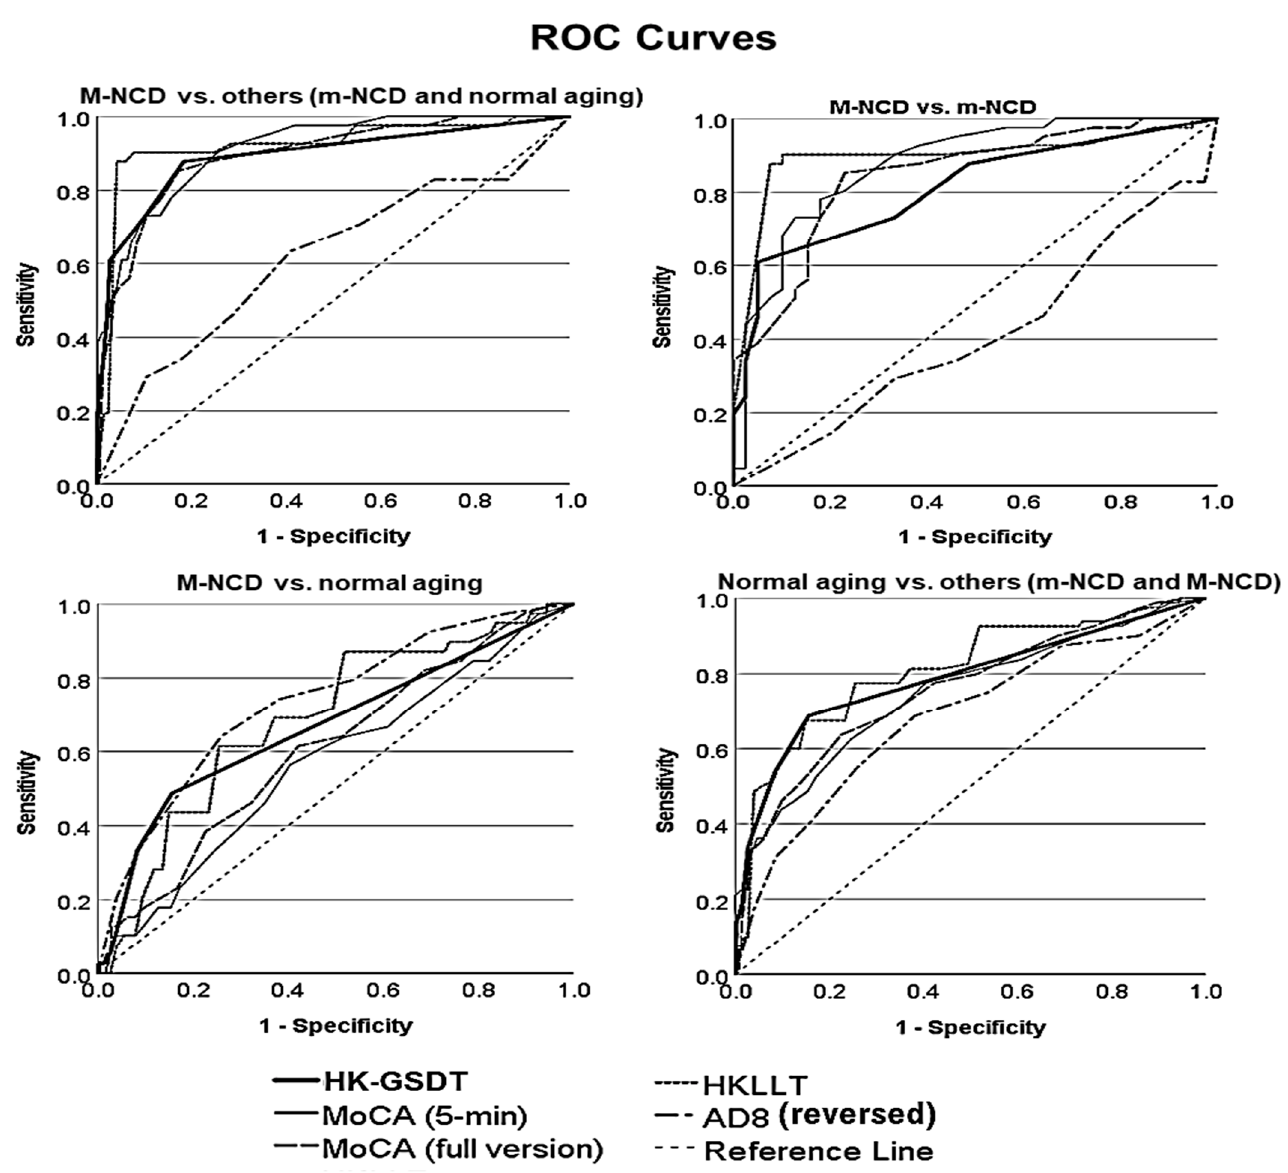
Figure 2. Receiver operating characteristic (ROC) curves for different tests to discriminate between cognitive conditions. A curve closer to the top-left corner indicates better performance in discriminating between cognitive conditions. HK-GSDT = Hong Kong Grocery Shopping Dialog Test; MoCA = Montreal Cognitive Assessment Hong Kong Version; HKLLT = Hong Kong List Learning Test (2nd Edition); AD8 = Eight-item Interview to Differentiate Aging and Dementia (the scores on AD8 were reversed coded, such that a higher score indicated poorer self-perceived cognitive